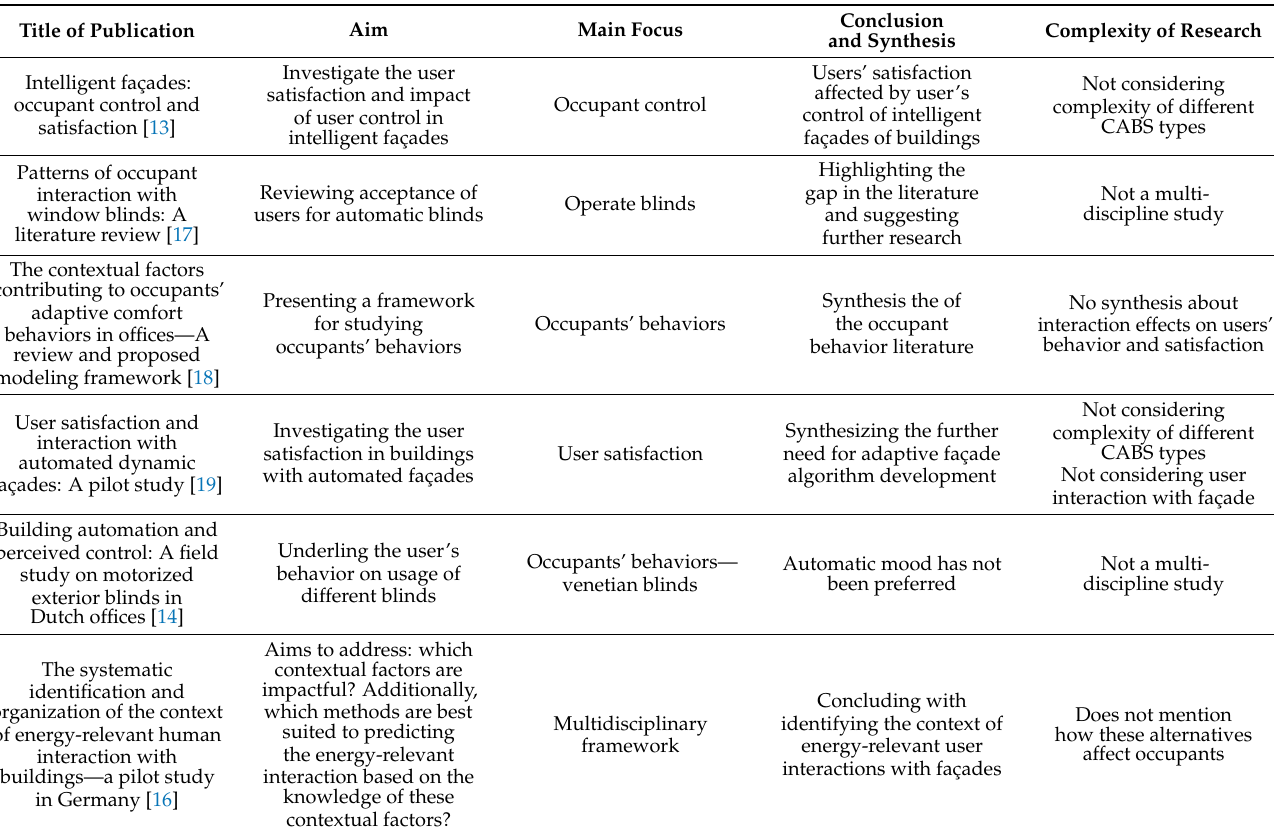
Table 2. Review on CABS user-centered studies from a building science point of